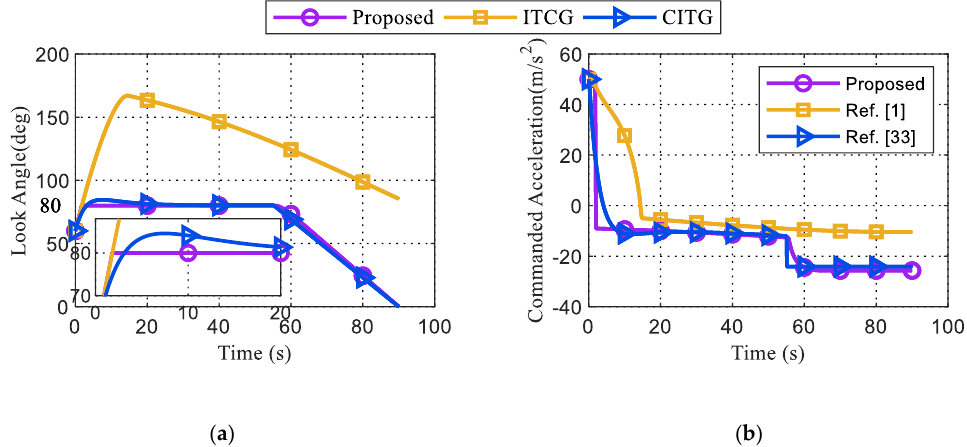
Figure 18. The results for different guidance laws for T d = 90 s. ( a ) Trajectories; ( b ) Distance to target.